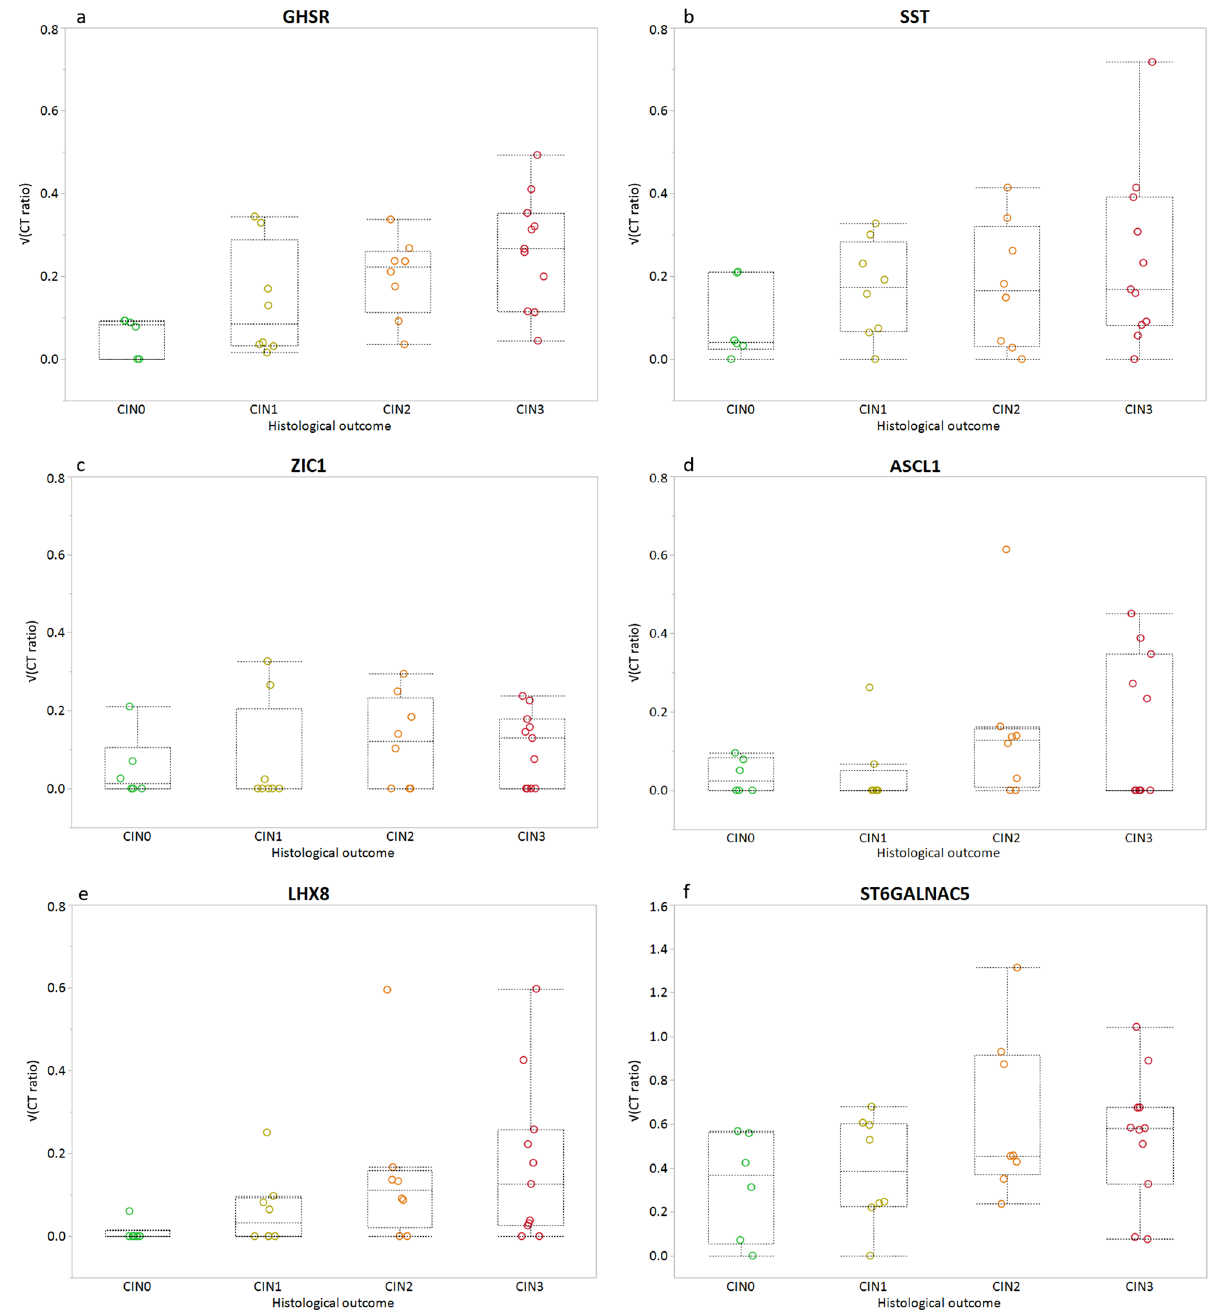
Figure 3. Host cell DNA methylation levels (square root transformed; y-axis) for ( a ) GHSR , ( b ) SST , ( c ) ZIC1 , ( d ) ASCL1 , ( e ) LHX8 , and ( f ) ST6GALNAC5 according to histological outcome (x-axis); normal/CIN0 (green circles, n = 6), CIN1 (yellow circles, n = 8), CIN2 (orange circles, n = 8), and CIN3 (red circles, n = 11). Box-plots indicate median methylation levels and according interquartile ranges (25th and 75th